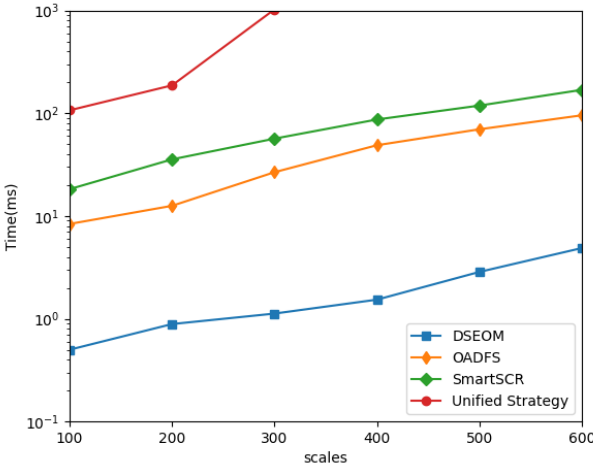
Figure 7. Time consumption under different scales.